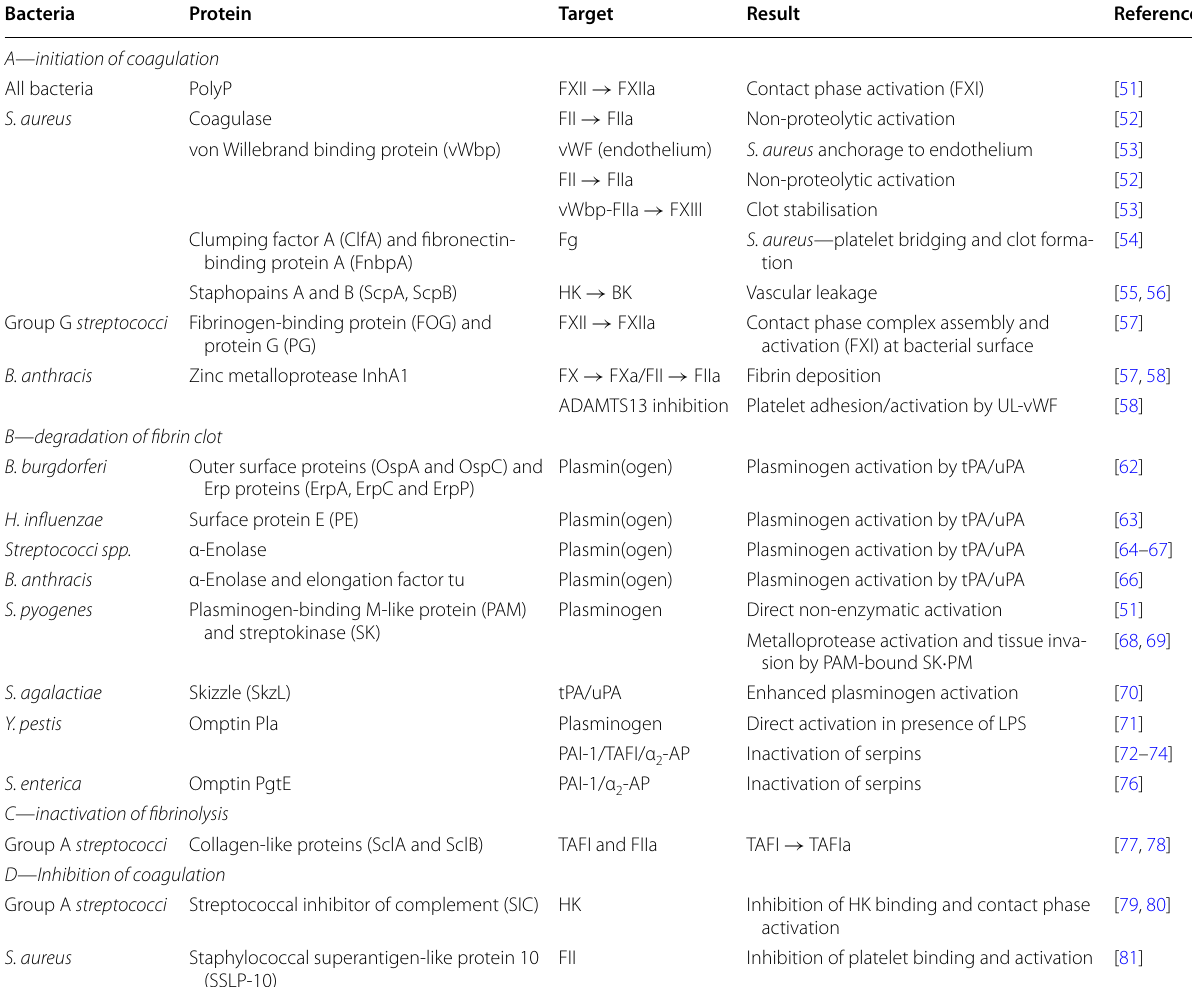
Table 1 Pathogen-induced modulation of blood coagulation